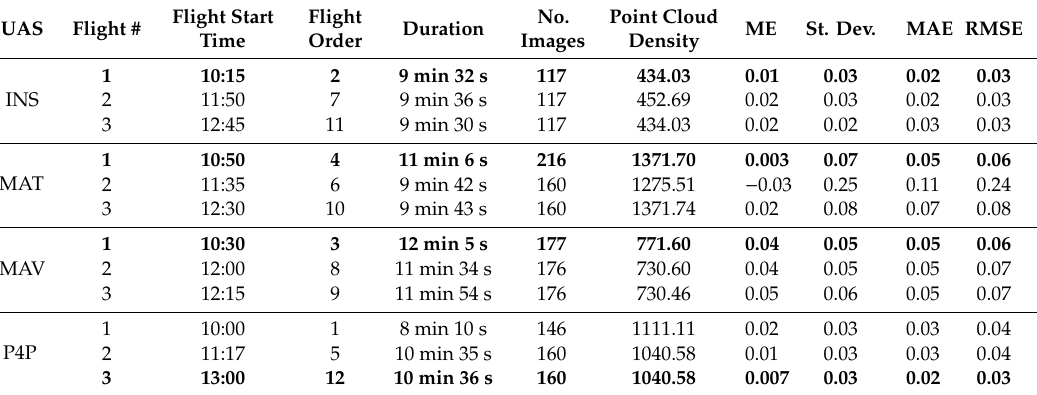
Table 4. Detailed flight information for each UAS flight. Error statistics represent overall di ff erences compared to 12 checkpoints across the study site. All times in Atlantic Standard Time (AST). The bolded flight indicates the best flight selected for further analysis. ME: Mean Error; St. Dev.: Standard Deviation of Error; MAE: Mean Average Error; RMSE: Root Mean Square Error. All errors reported in meters (m). Point cloud density shown in points per square meter (pts / m 2 ).